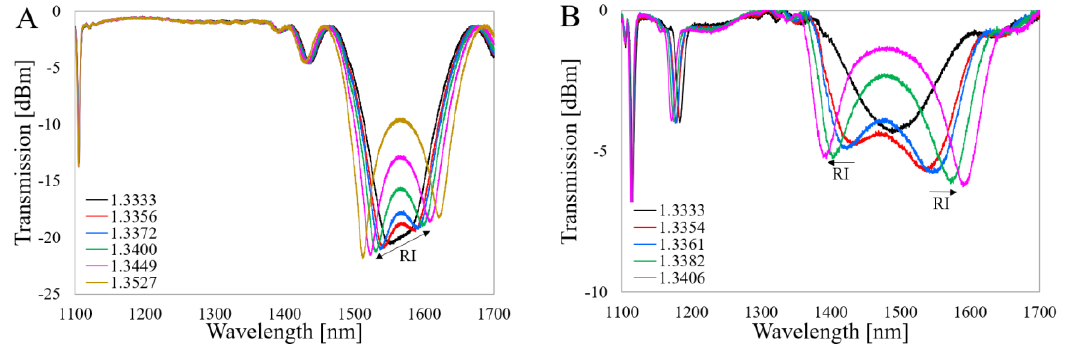
Figure 3. Spectral response of the investigated structures ( a ) LPG and ( b ) Al 2 O 3 -LPG to changes in refractive index (RI). The arrows indicate a spectral shift with external RI.